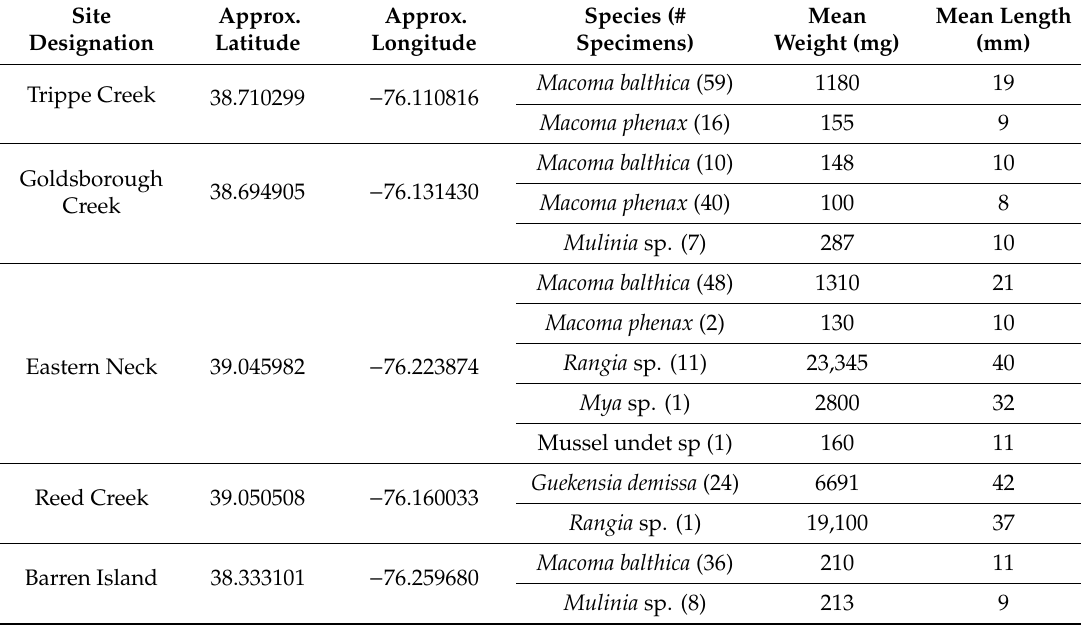
Figure 1. Sampling locations for bivalve mollusk collections in Chesapeake Bay and its tributaries. Table 2. Bivalve species sampled from Chesapeake Bay and tributaries, November 2015.